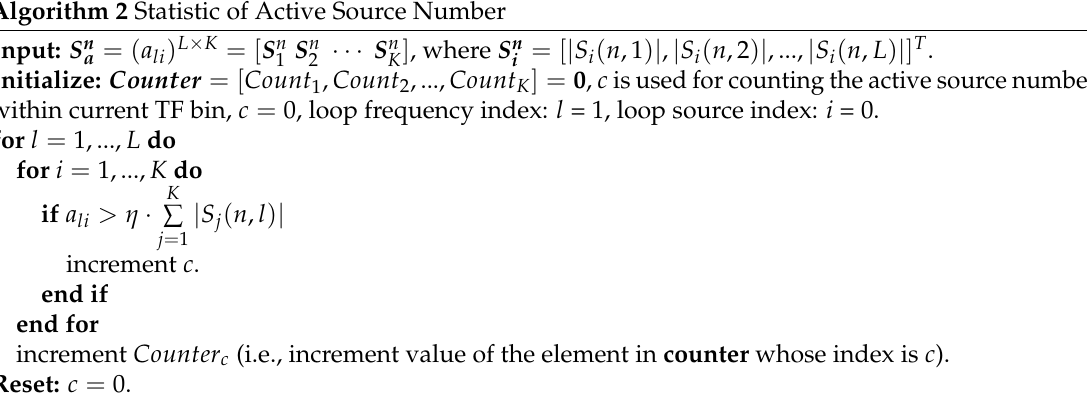
Algorithm 2 Statistic of Active Source